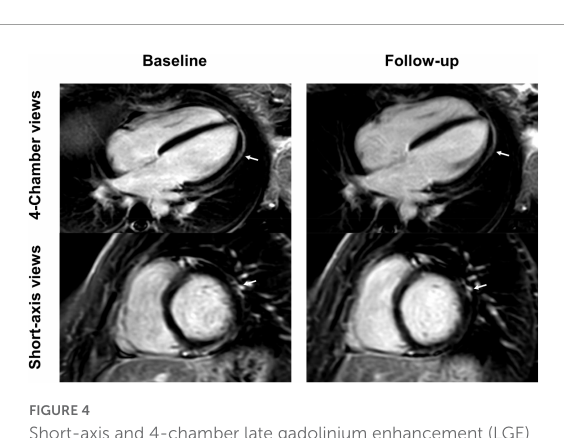
FIGURE4 Short-axis and 4-chamber late gadolinium enhancement (LGE) views in a 26-year-old, previously healthy female after receiving the first dose of the Pfizer/BioNTech vaccine. Nearly complete resolution of LGE (arrows) at follow-up 2 months later with minor enhancement discernable at the apical lateral segment. Clinical correlation showed a complete resolution of previous symptoms which included chest pain and exertional